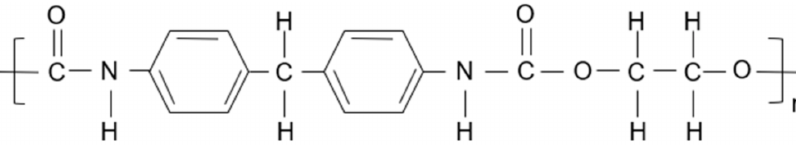
Figure 2. Chemical compound of polyurethane (wood surface).